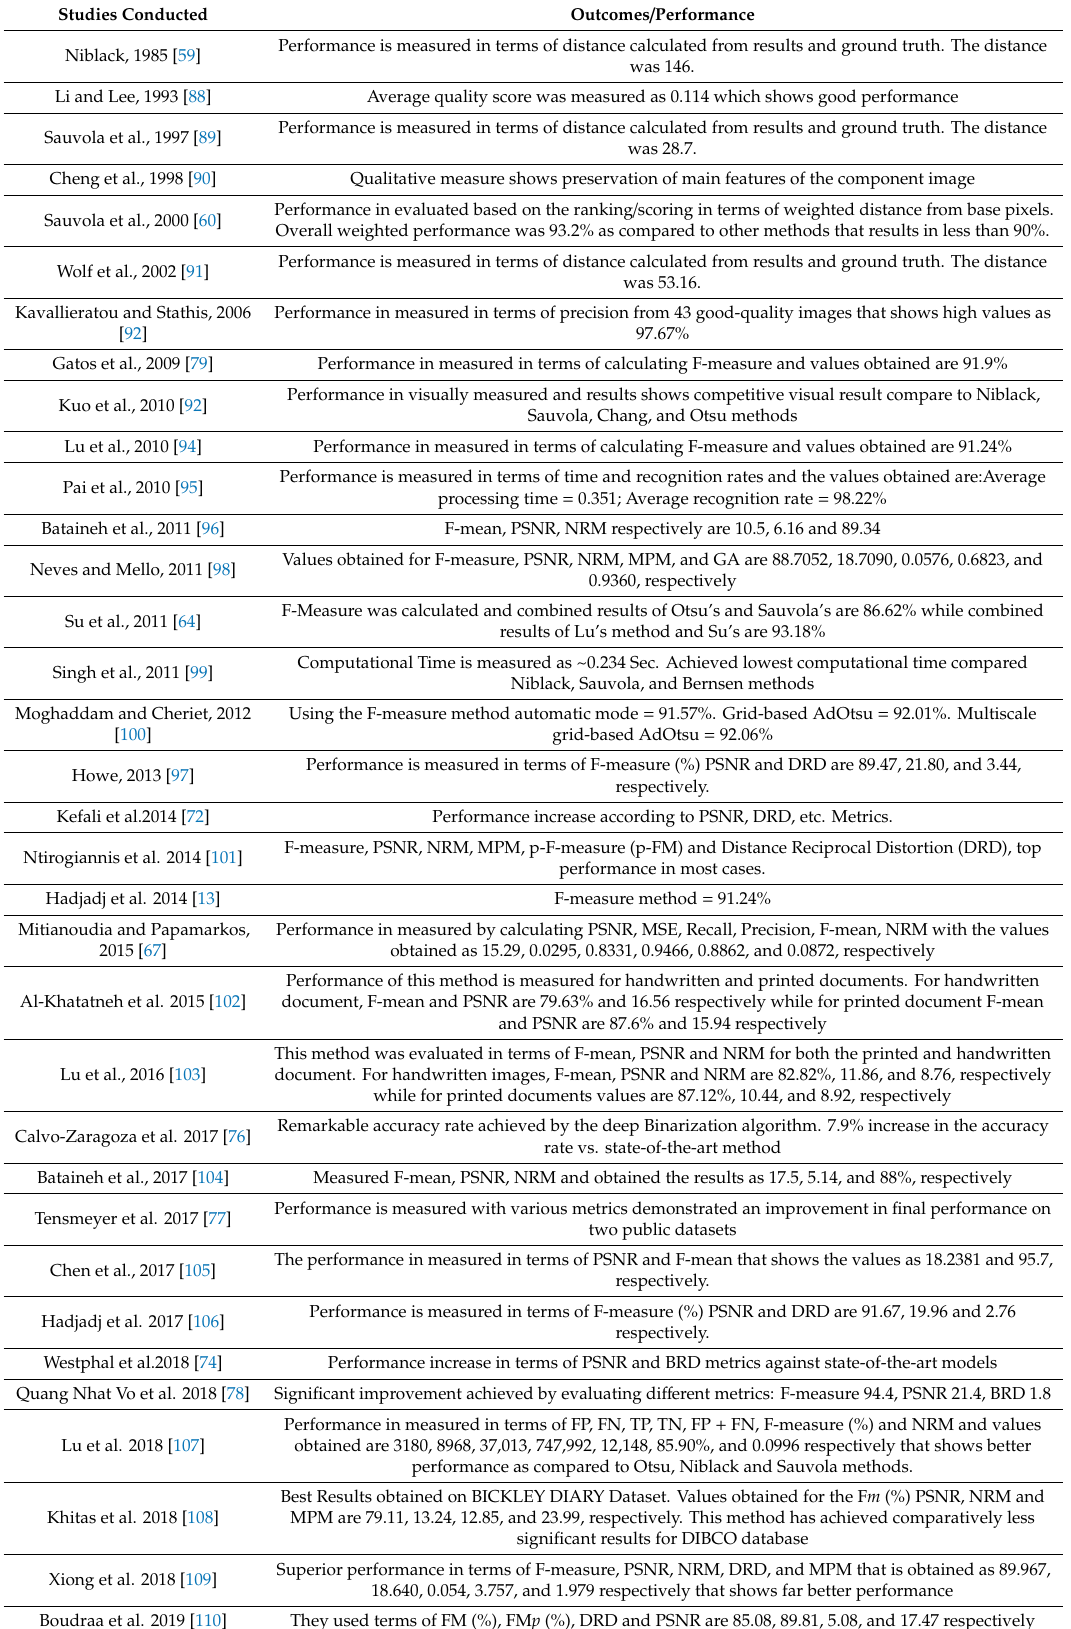
Table 1. Comparison of popular document binarization methods for degraded